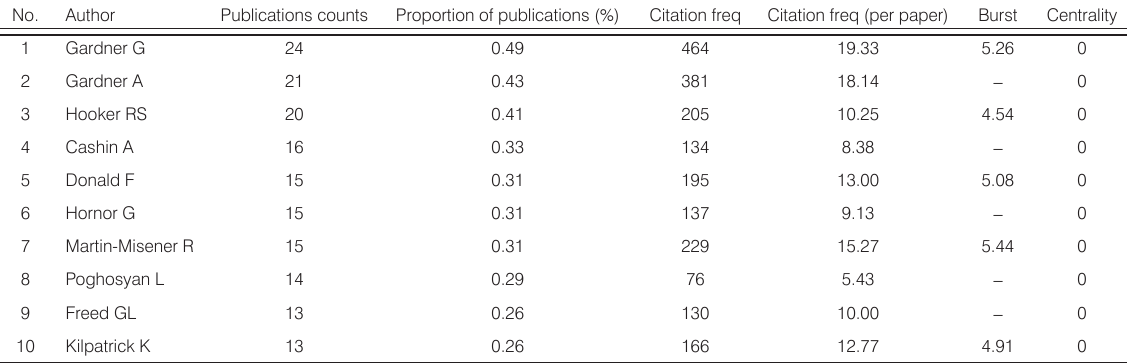
No. Proportion of publications (%) Citation freq Citation freq (per paper)